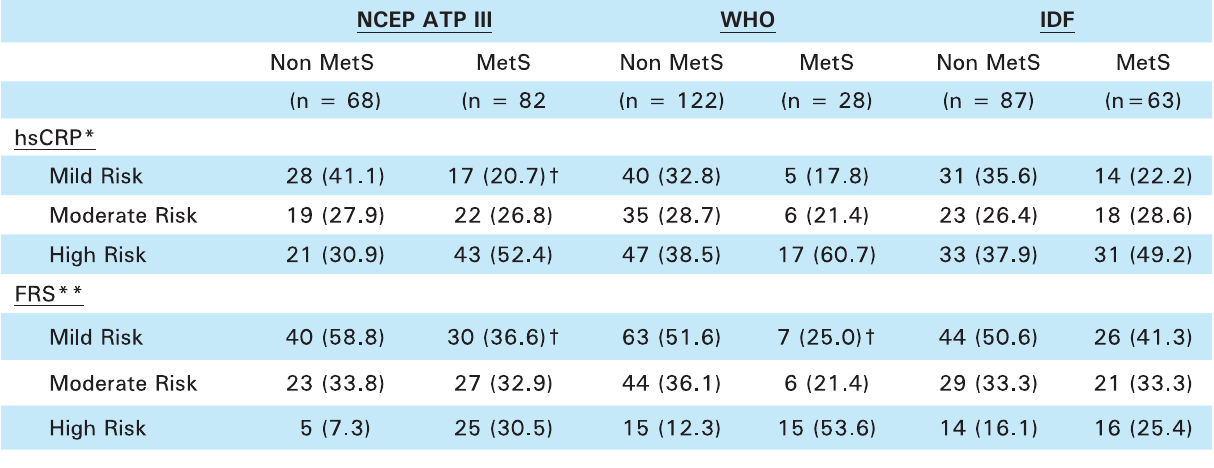
Table 4. Association of the grade of risk according to hsCRP and FRS among Mets by the three de fi